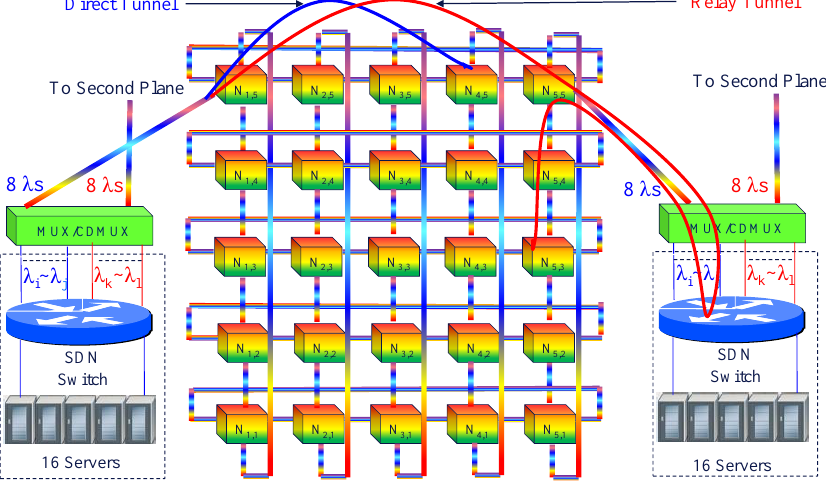
Figure 6. Tunnel creation of first plane.